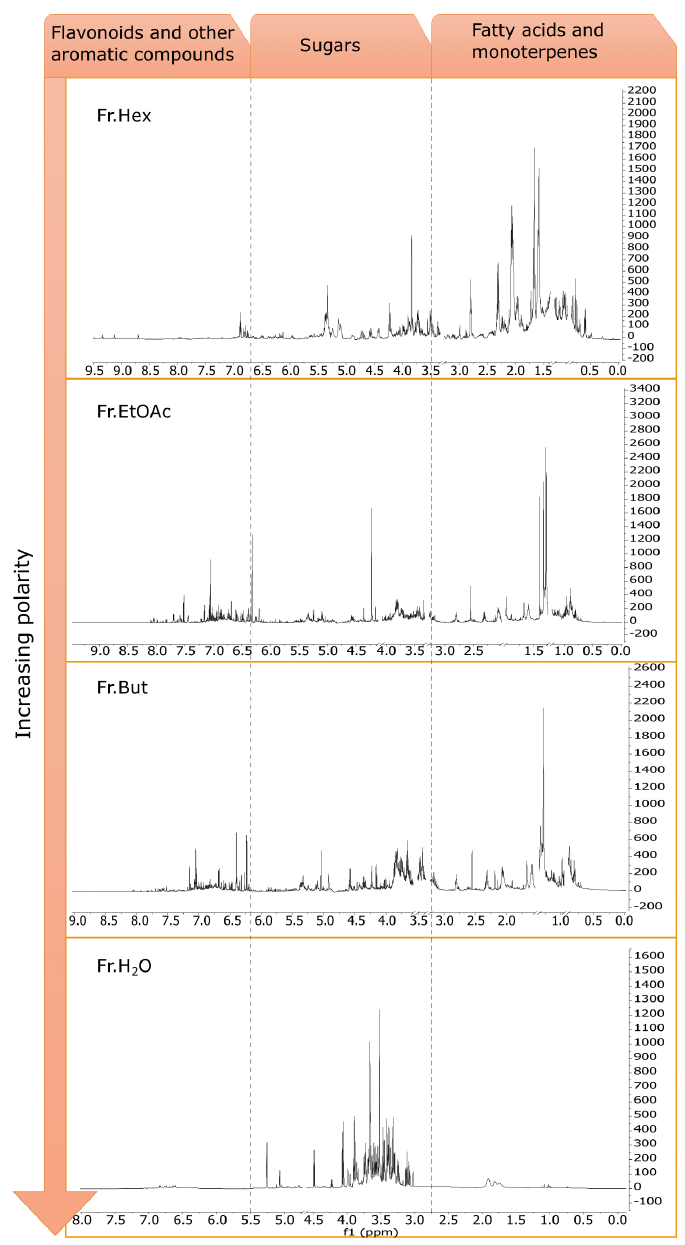
Figure 6. 1 H NMR profiling of the four fractions obtained by liquid/liquid partition of chestnut leaf extract (L). Spectral regions with the residual solvent signals were removed. Spectra of Fr. Hex, Fr. EtOAc and Fr. But were measured in CD 3 OD. The spectrum of Fr. H 2 O was acquired in a blend of CD 3 OD:D 2 O